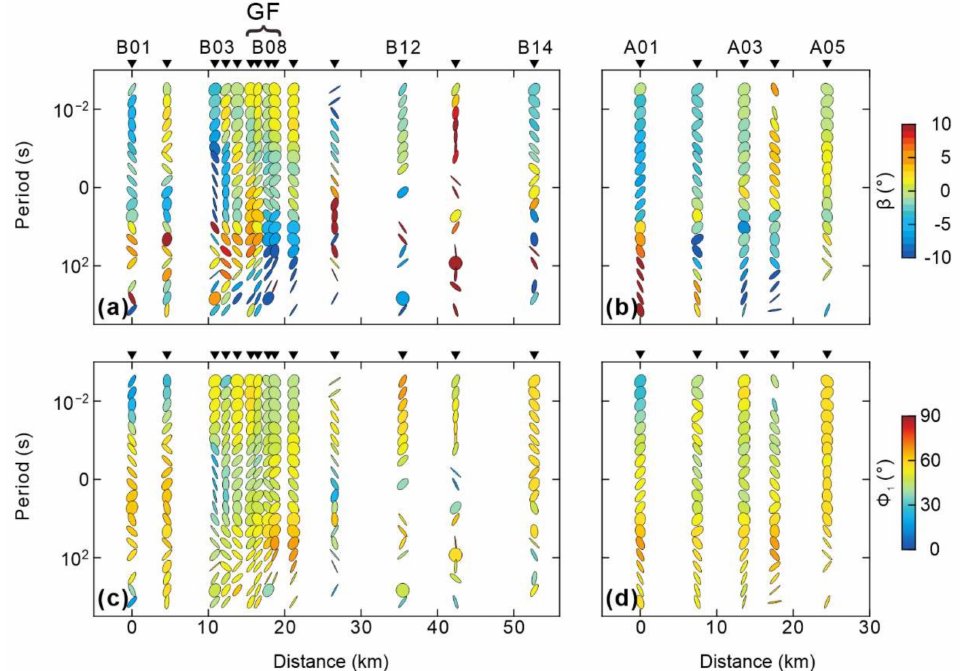
Figure 5. Pseudo-sections of normalized phase tensor ellipses with the values of β ( a , c ) and Φ 1 ( b , d ) as a function of the period for all periods and sites along two profiles. Each ellipse denotes the phase tensor for a single period at a single MT